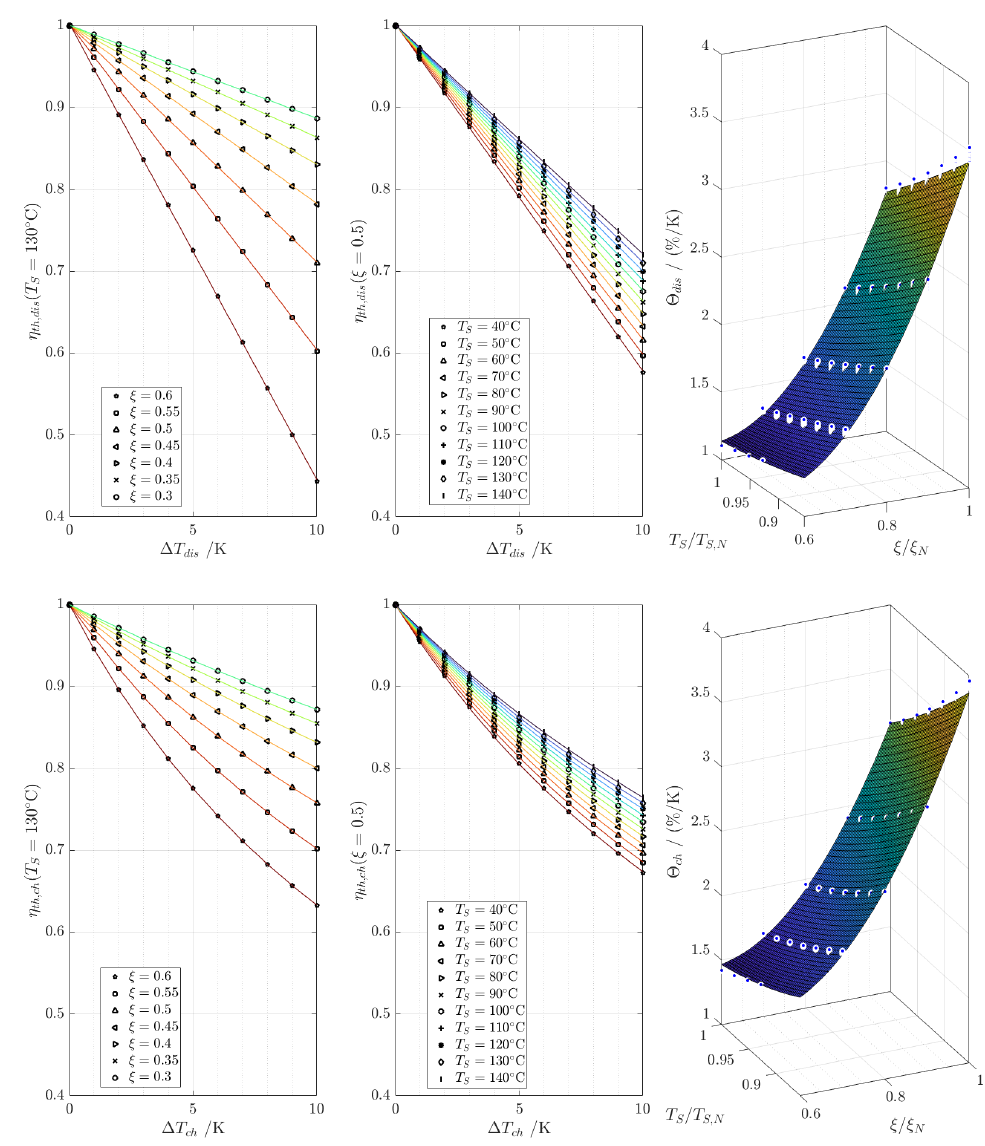
Figure 9. Thermal efficiency η th and calculated proportionality factor Θ dis / ch (Equations (7) and (8)) in dependence of storage temperatures and working-fluid mass fraction for discharging ( top ) and charging ( bottom